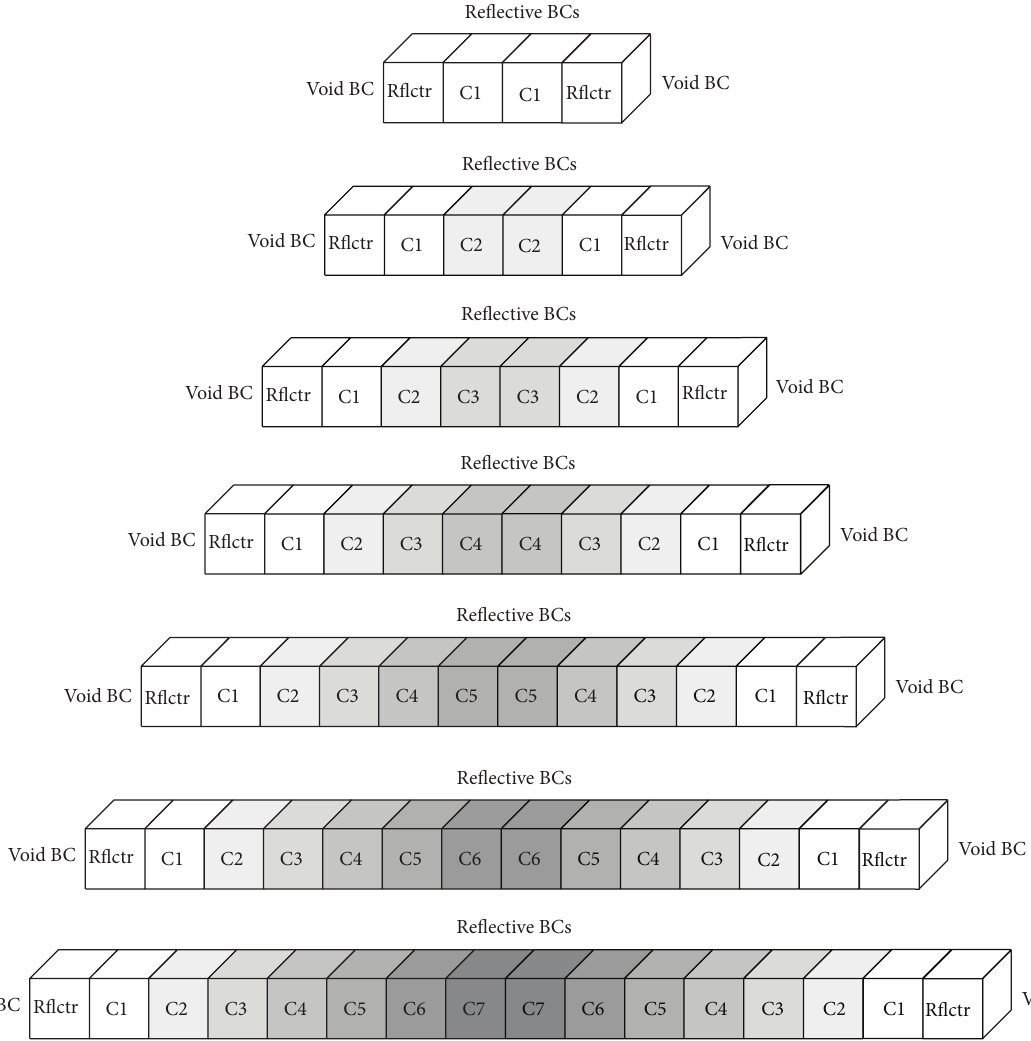
Figure 17: Partial 3D fuel channels with axial reflector cells developed for the study of the cells at the